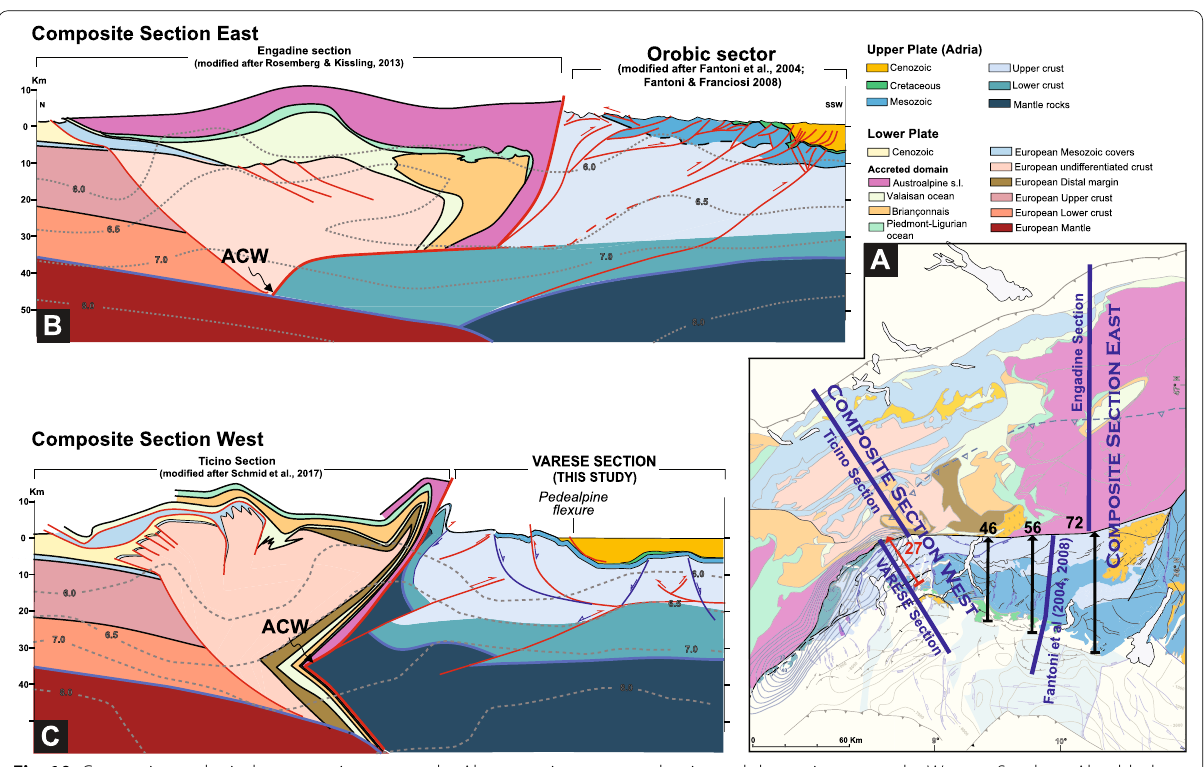
Fig. 10 Composite geological cross-sections across the Alps: a section traces and estimated shortening across the Western Southern Alps: black lines from Handy et al., 2015; red line, this study); b Composite Section East (Engandine-Orobic Alps), after Rosenberg and Kissling (2013) and Fantoni et al. (2004); Fantoni and Franciosi (2008)—modified; c Composite Section West, including the Ticino section to the north (modified after Butler, 1986 and Schmid et al., 2017), integrated with the Varese Section, to the south (this